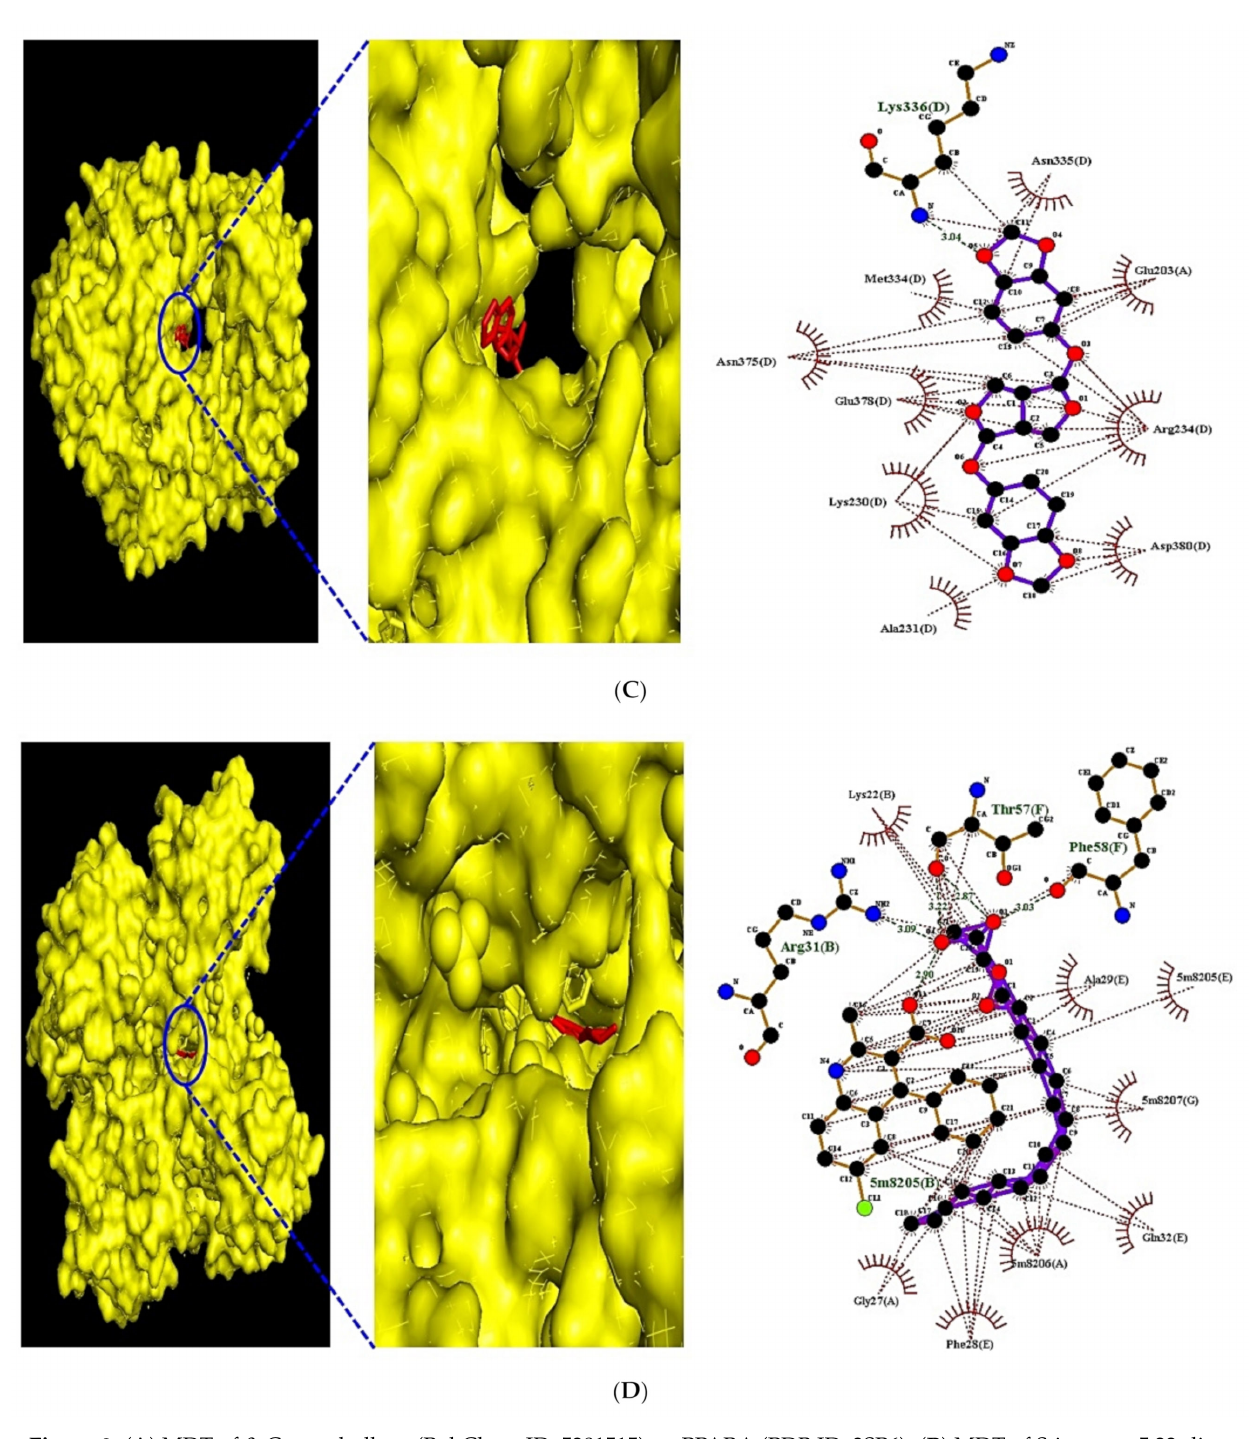
Figure 9. ( A ) MDT of β -Caryophyllene (PubChem ID: 5281515) on PPARA (PDB ID: 3SP6). ( B ) MDT of Stigmasta-5,22-dien- 3-ol (PubChem ID: 53870683) on PPARD (PDB ID: 5U3Q). ( C ) MDT of NSC402953 (PubChem ID:345349) on PPARG (PDB ID: 3E00). ( D ) MDT of monoolein (PubChem ID: 5283468) on FABP3 (PDB ID: